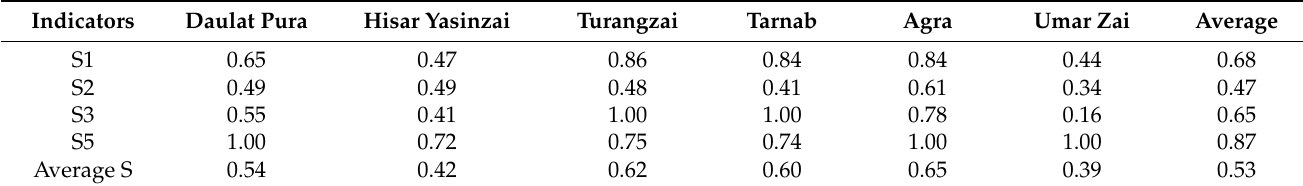
Table 5. Household susceptibility to